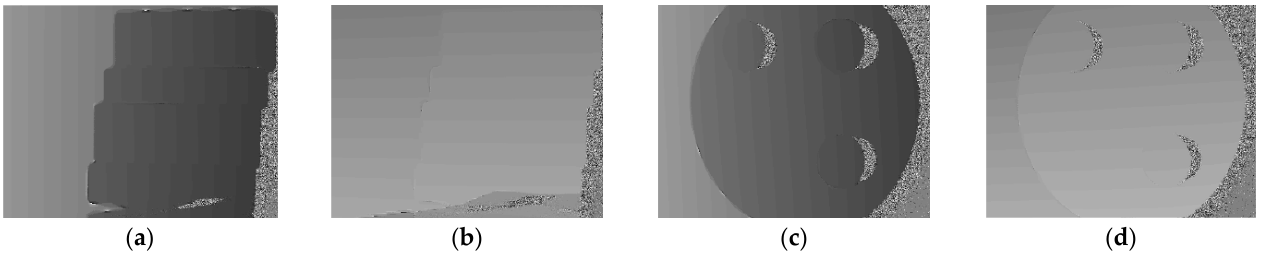
( a ) ( b ) Figure 11. The 3D shape of two samples: ( a ) rectangular step; ( b ) circular step gauge. Limited by the manufacturing accuracy, the surfaces of the circular step gauge in Figure 11b are not parallel, but it can be seen from its reconstruction results that the pro- posed method can achieve the measurement of structured specular surfaces. The rectan- gular gauge in Figure 11a has four parallel planes, so the relative height between adjacent steps can be used to evaluate the measurement accuracy of discontinuous surfaces. By fitting the 3D data of four separate surfaces obtained by the proposed method into ideal planes, the height differences between every two adjacent surfaces can be calculated, as shown in the third column of Table 2. For comparison, the corresponding height data were also measured by CMM (within a measuring accuracy of 2 µm). The measurement of each isolated surface of the sample is realized by measuring the depth information of 8 to 10